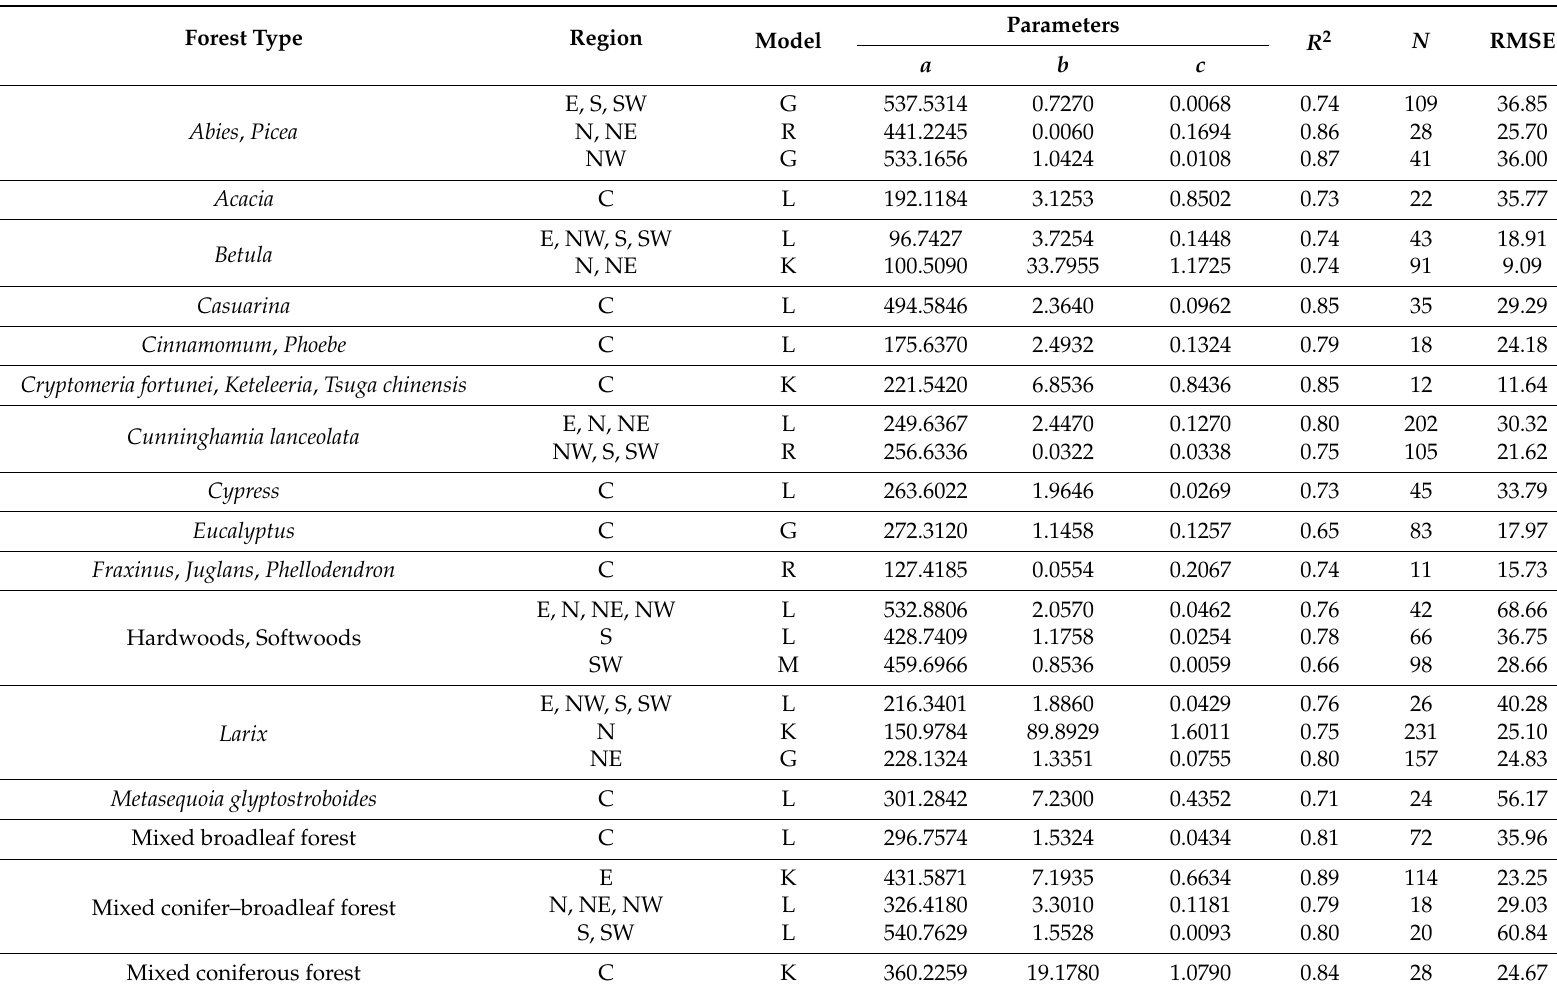
Table 2. Fitted parameters of biomass–age relationships for different types of forests in each region of China based on stand growth models a